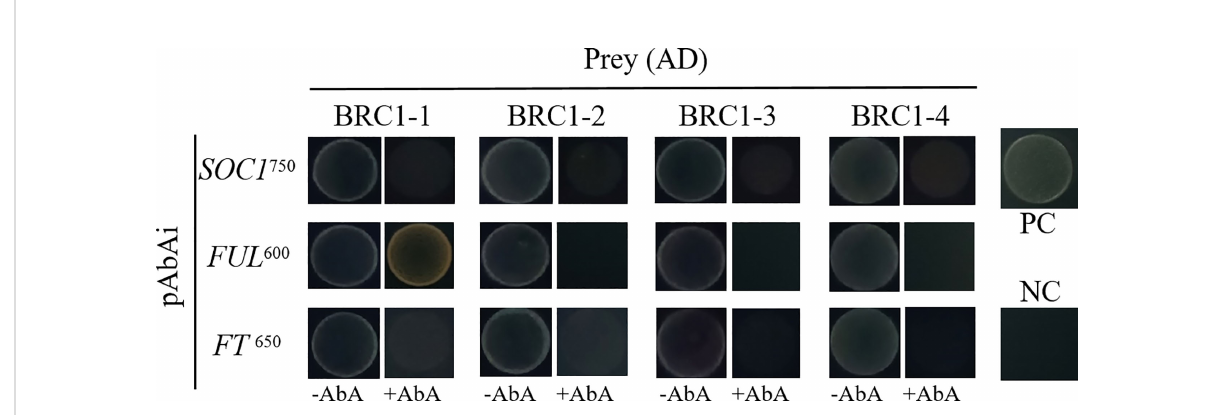
FIGURE 6 Yeast one hybrid assay. Yeast one-hybrid assay to test whether the four BjuBRC1 proteins could directly bind to the promoters of BjuFT , BjuFUL , or BjuSOC1 . pGADT7- BjuBRC1s was transformed into yeast Y1H strains in combination with pAbAi- ProBjuFT , pAbAi- ProBjuFUL , and pAbAi- ProBjuSOC1 , respectively. The transformed strains all were grown on SD/-Leu selective media containing aureobasidin A (ABA) (650, 600, and 750 m g/l, respectively). PC, positive control; NC, negative